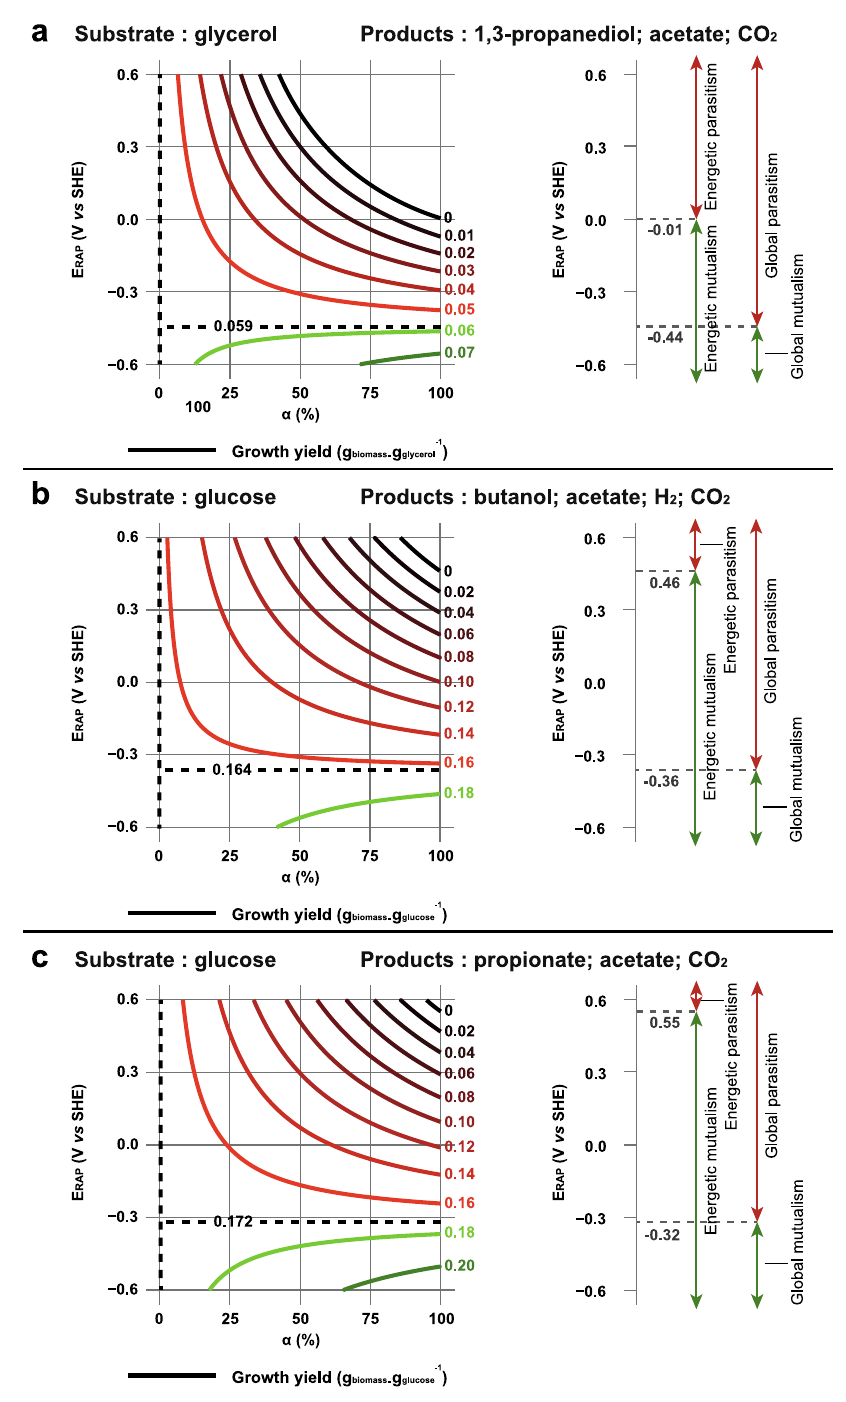
Figure 3. Growth yield map for a fermentative species uptaking extracellular electrons during a fermentation. ( a ) Glycerol fermentation by C. pasteurianum . ( b ) Glucose fermentation by C. pasteurianum . ( c ) Glucose fermentation by P. freudenreichii . Dashed lines represent contour line for the specific value obtained when α = 0 (fermentative growth yield). Solid lines represent contour lines of growth yields. These lines are green or red when higher or lower than the fermentative growth yield, respectively. Interactions are described as “Energetic” regarding energy partitioning during IET and as “Global” when biomass production of each IET partner is considered. α : fraction of substrate used for dissipating electrons from IET (normalized on substrate consumption for catabolism); E RAP : Potential of the redox active protein involved in the electron dissipation reaction; SHE: Standard Hydrogen